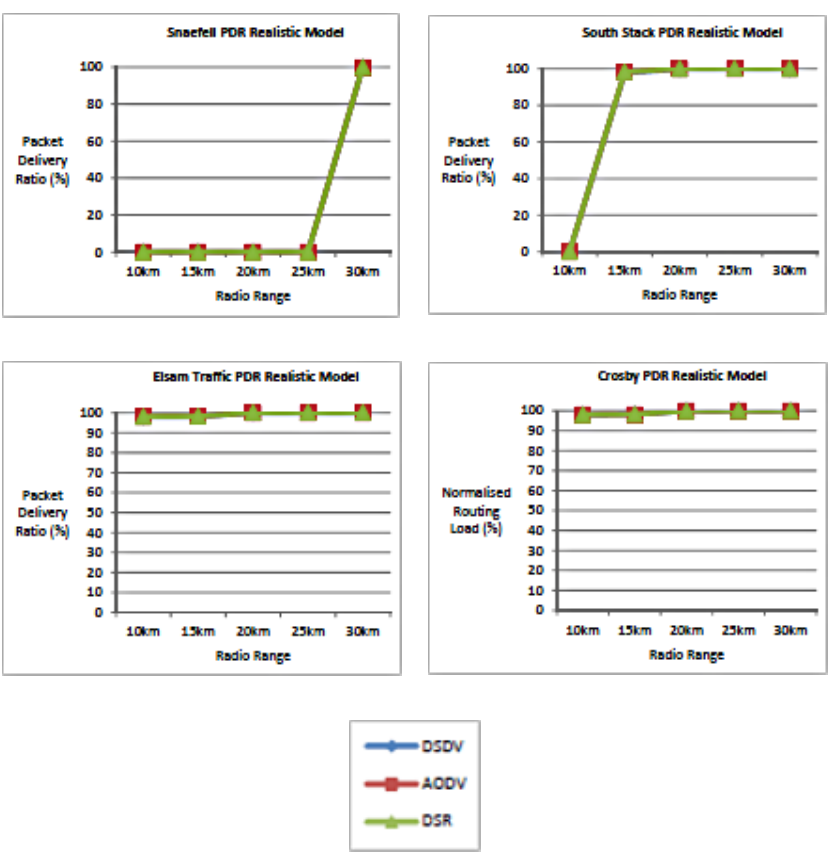
Figure 12. Realistic Shipping Model Packet Delivery Ratios (PDRs).